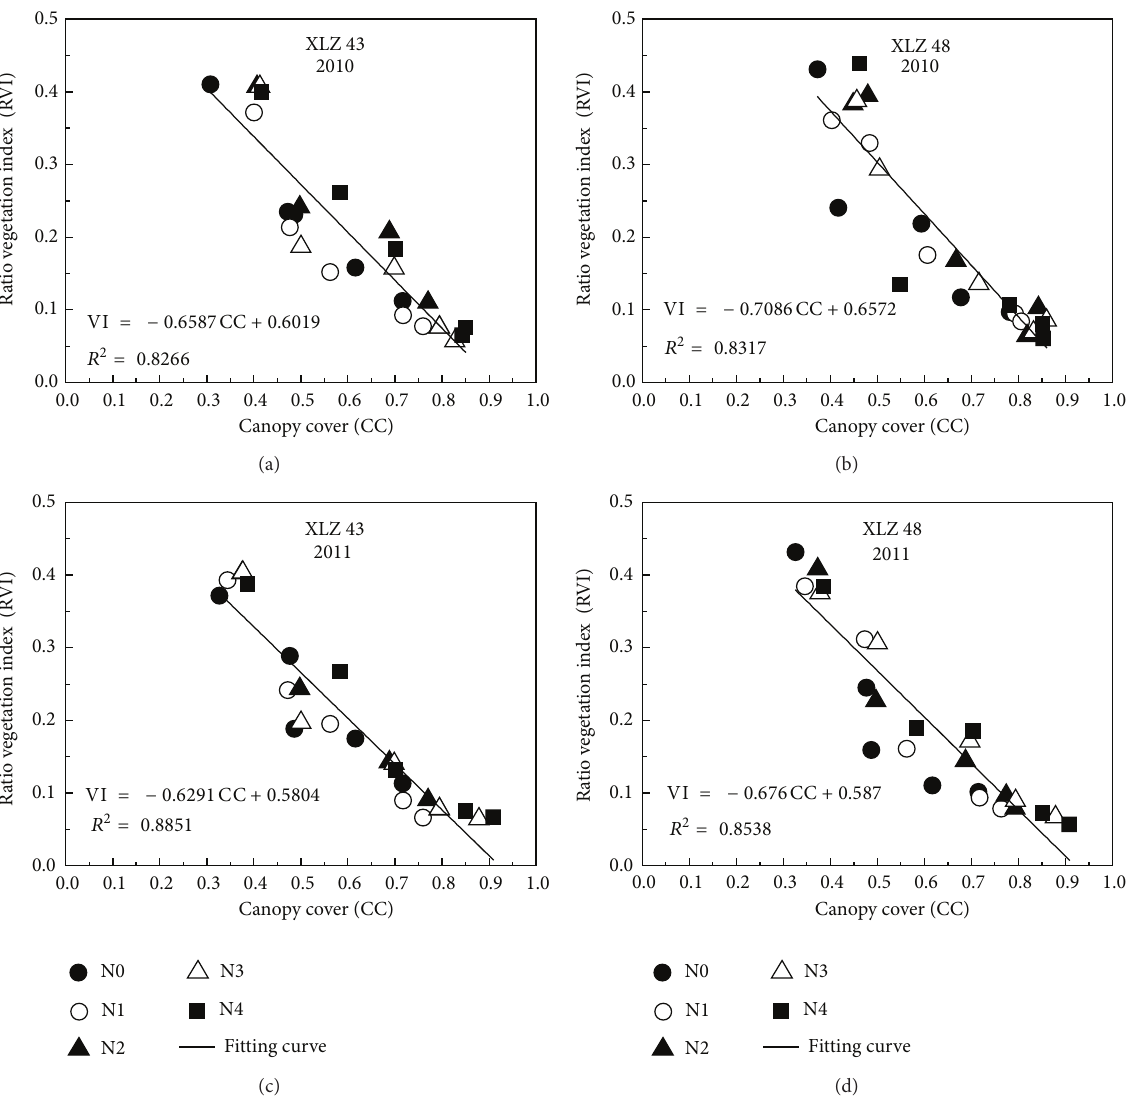
Figure 4: Results from experiment 1 showing the relationship between canopy cover calculated from digital images and ratio vegetation index (RVI) estimated using a GreenSeeker handheld sensor. (a) Cotton cultivar “XLZ 43” in 2010; (b) cotton cultivar “XLZ 48” in 2010; (c) cotton cultivar “XLZ 43” in 2011; (d) cotton cultivar “XLZ 48” in 2011.